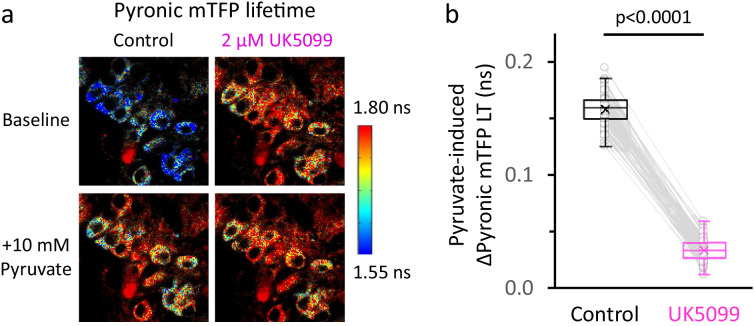
The rise in [pyruvate]CYT due to MPC inhibition almost saturates the Pyronic sensor.(a) Representative images of DGCs expressing the Pyronic sensor, pseudocolored according to the lifetime of the donor species (mTFP). Cells perfused in ACSF only (Control), or in the presence of the MPC inhibitor UK5099, are shown before and after the application of 10 mM pyruvate as in Figure 2a. Images in the bottom were taken at the peak value of the response to pyruvate. The color scale bar to the right shows the range of lifetime for Pyronic mTFP. (b) The change in the Pyronic mTFP lifetime (LT) in response to external pyruvate application was diminished in DGCs after incubating with UK5099. Data points obtained before and after the application of UK5099 are connected by lines. The data were compared using a paired Student’s t’s test (Nneurons = 82, Nslices = 7 and Nmice = 4).